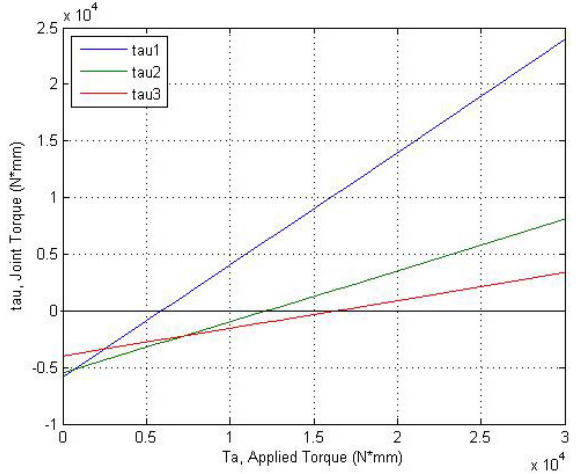
Figure 6. Closing sequence with small preload.